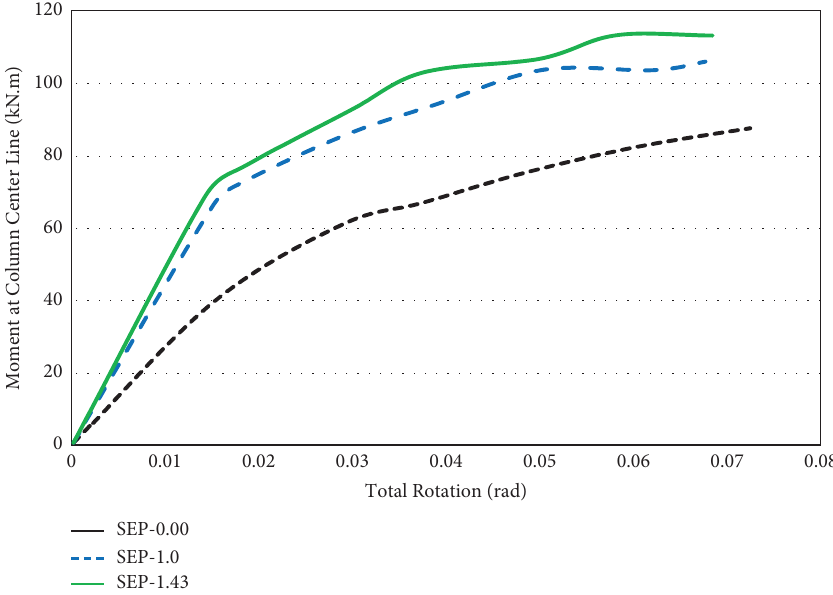
Figure 11: Envelope of moment-rotation hysteresis curve of the